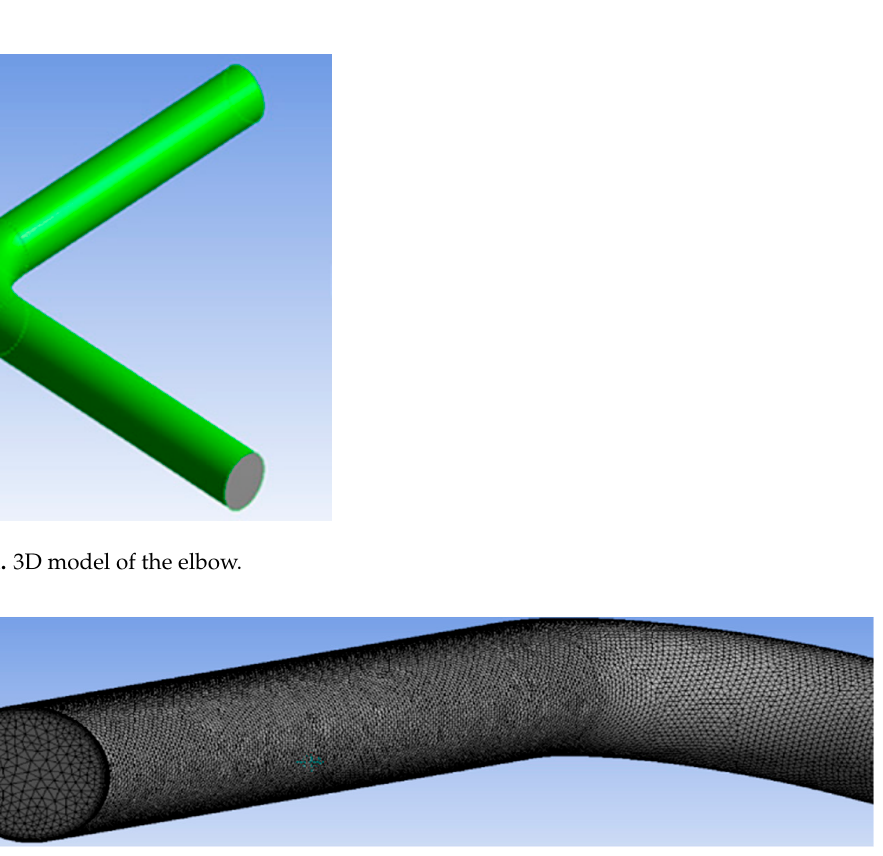
Figure 5. The mashing result.